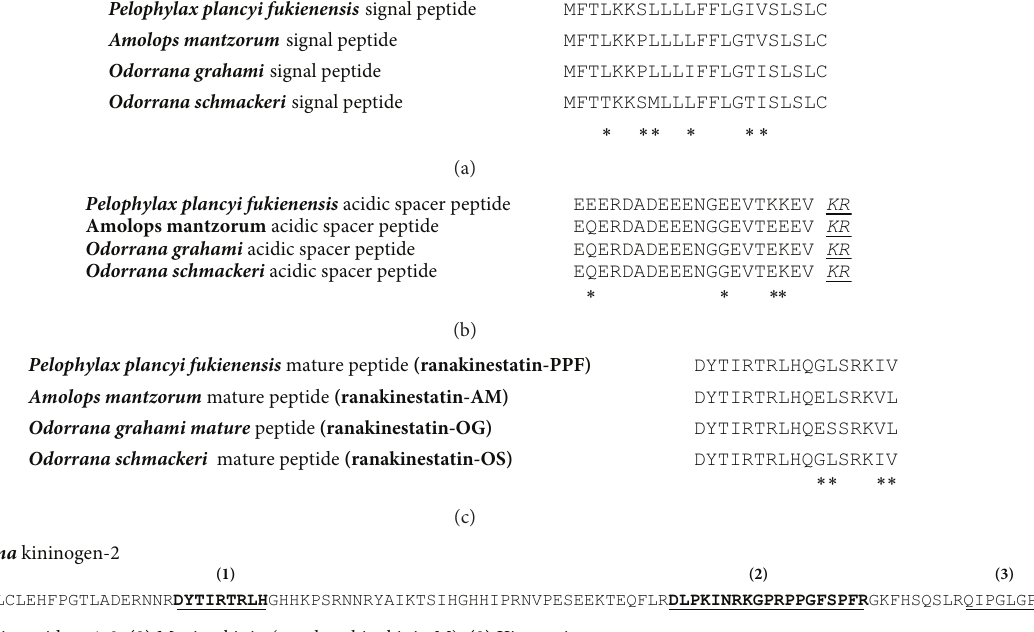
Figure 4: Bioinformatic analysis of the ranakinestatin-PPF biosynthetic precursor with homologs reported from other amphibian sources. Accessionnumbersforcitedsequencesare Pelophylaxplancyifukienensis ranakinestatin-PPF(HG518554), Amolopsmantzorum antimicrobial peptidemantzorumin-B 1 (ADM34242), Odorranagrahami odorranaopin(ADP37000), Odorranaschmackeri ranakinestatin-OS(HG518555), and Bombina maxima skin kininogen-2 (P83055). (a) Comparison of putative N-terminal signal peptide domains of respective biosynthetic precursors. Sites of amino acid differences are indicated with asterisks (6/22). (b) Comparison of acid spacer peptide domains of respective biosynthetic precursors. Sites of amino acid differences are indicated with asterisks (4/20). Note that this domain terminates in the conserved basic amino acid residue doublet (-KR-) (indicated in italics and underlined) that represents the site of propeptide convertase cleavage generating the mature peptide. (c) Comparison of mature (ranakinestatin) peptide domains of respective biosynthetic precursors. Sites of amino acid differences are indicated with asterisks (4/17). (d) The full-length sequence of Bombina maxima skin kininogen-2 indicating domains containing (1) the fully conserved ranakinestatin residues 1–9, (2) the bradykinin receptor agonist peptide, maximakinin (syn. bombinakinin M), and (3) the bradykinin B 2 -receptor antagonist peptide,